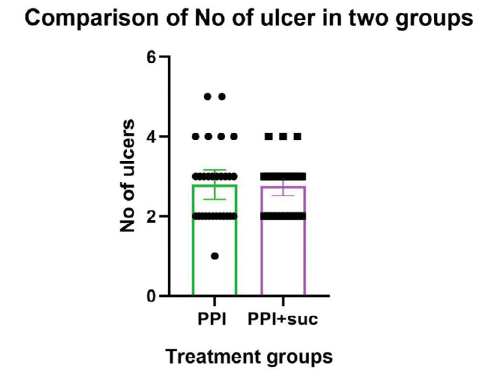
Figure 3: Comparison of number of ulcers in both the groups